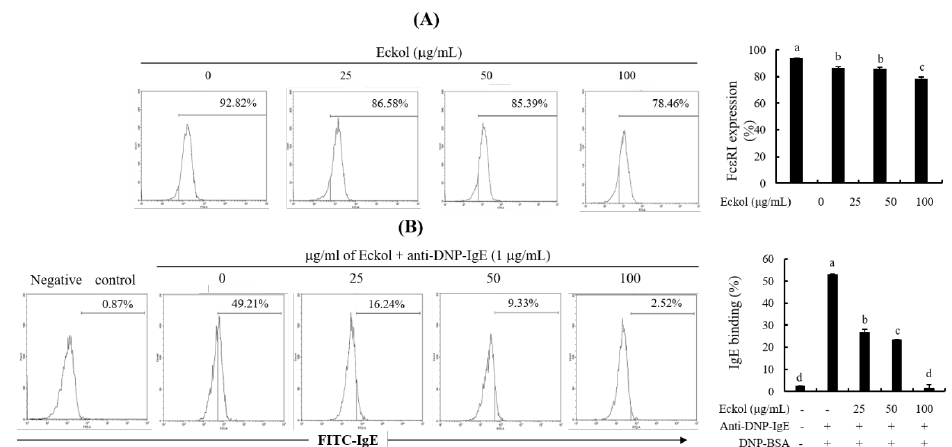
Figure 6. E ff ect of eckol on the cell surface expression of Fc ε RI and binding of IgE to Fc ε RI. ( A ) Cell Figure 6. Effect of eckol on the cell surface expression of Fc  RI and binding of IgE to Fc  RI. ( A ) Cell surface Fc ε RI expression and ( B ) IgE antibody binding to Fc ε RI. Data are expressed as means ± SD surface Fc  RI expression and ( B ) IgE antibody binding to Fc  RI. Data are expressed as means ± SD ( n ( n = 3) of three individual experiments. Di ff erences in mean values among groups were assessed by = 3) of three individual experiments. Differences in mean values among groups were assessed by one- one-way analysis of variance followed by Duncan’s test using PASW statistics 21.0. A value of p < 0.05 way analysis of variance followed by Duncan’s test using PASW statistics 21.0 . A value of p < 0.05 was considered statistically significant. was considered statistically significant.